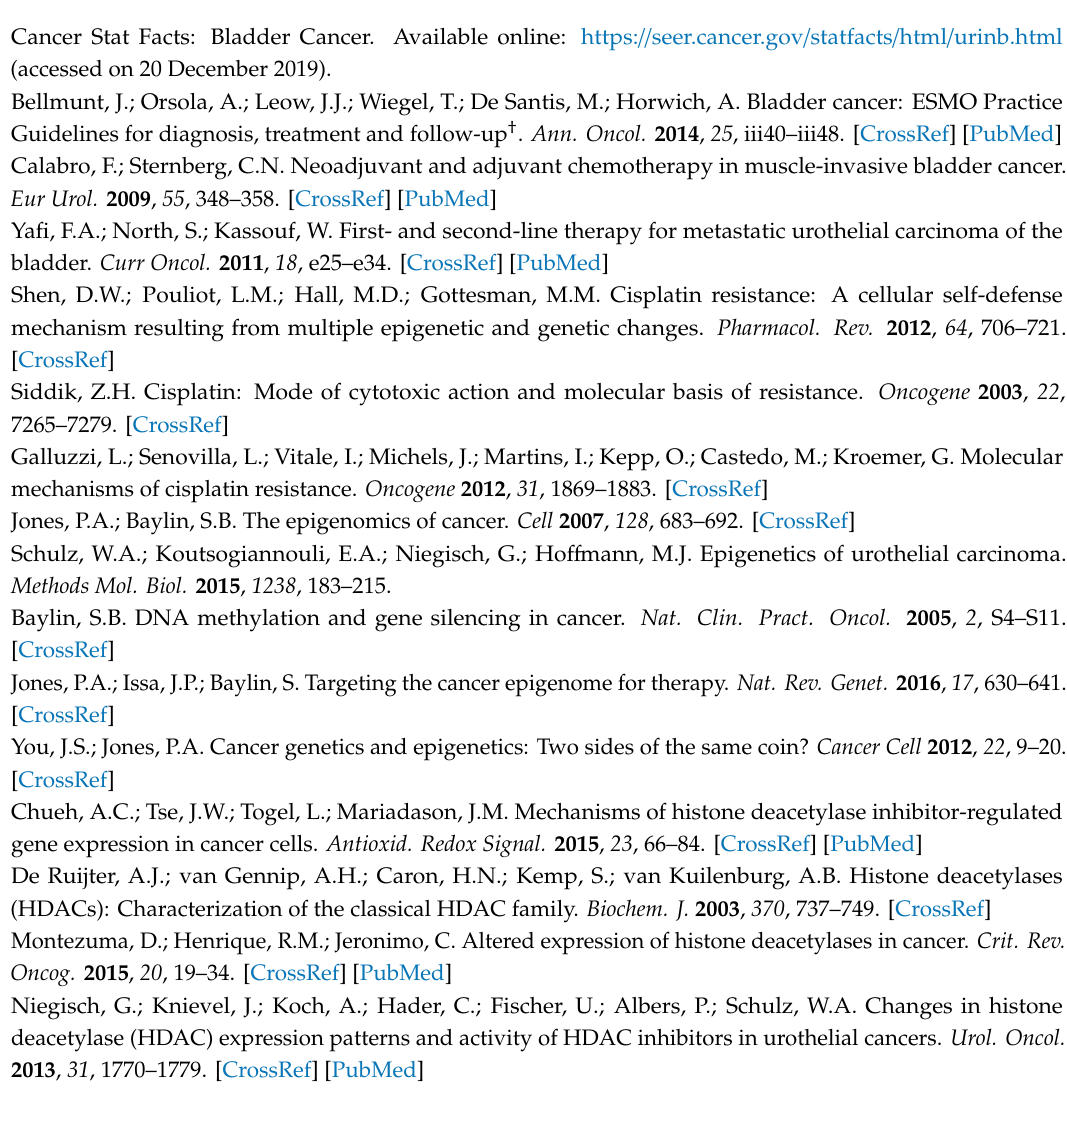
treatment of DAC or ENT with cisplatin, Figure S3: Uncropped Western blots and ratios of integrated densities of proteins of interest and beta-actin from J82 cells, Figure S4: Uncropped Western blots and ratios of integrated densities of proteins of interest and beta-actin from J82CisR cells, Figure S5: Uncropped Western blots and ratios of integrated densities of proteins of interest and beta-actin from RT-112 cells, Figure S6: Kaplan-Meier plot showing relapse free survival of 187 bladder cancer patients with low or high FoxO1 expression